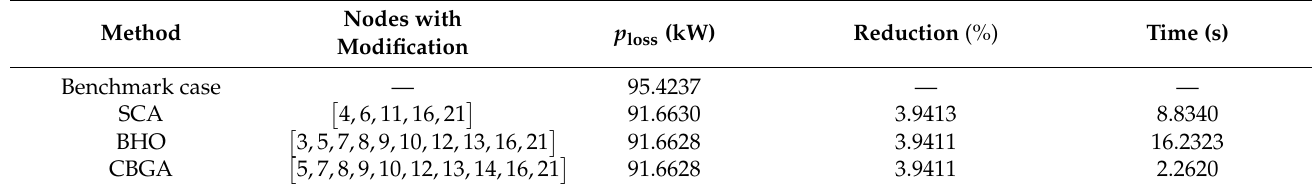
Table 3. Results of the 21-bus system for the proposed metaheuristic